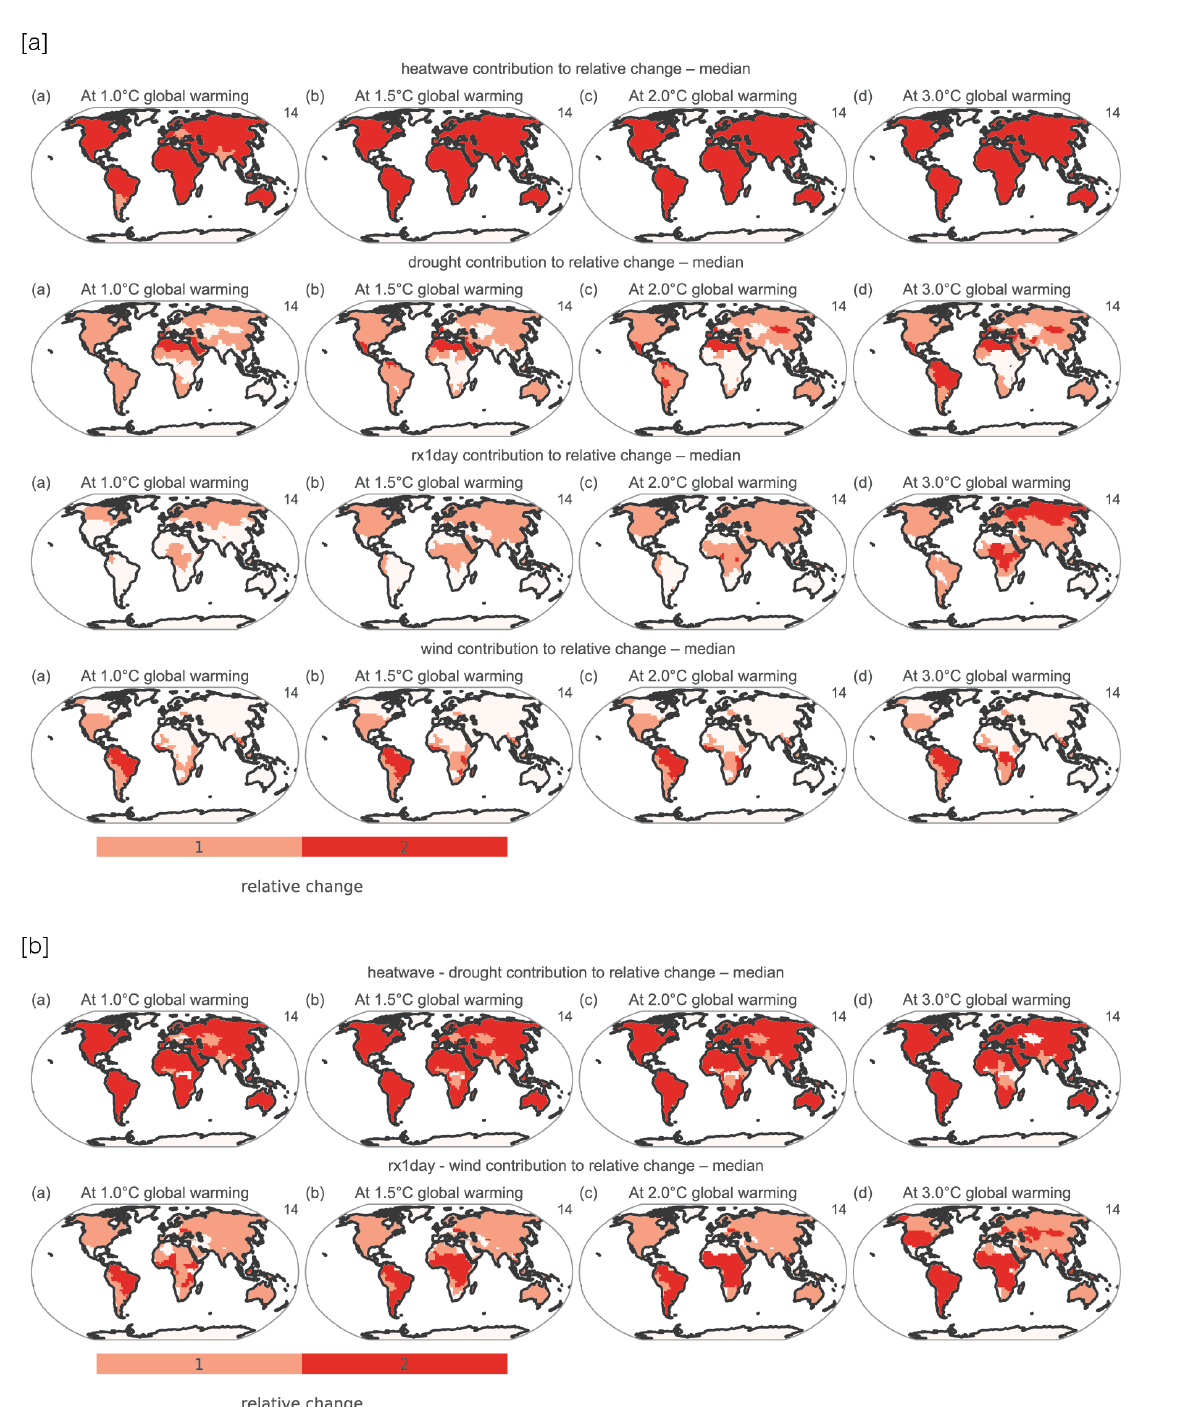
Figure B1. The 20% relative change (shown with 1) and 100% relative change (shown with 2) of each individual extreme [a] and concurrent extreme [b]